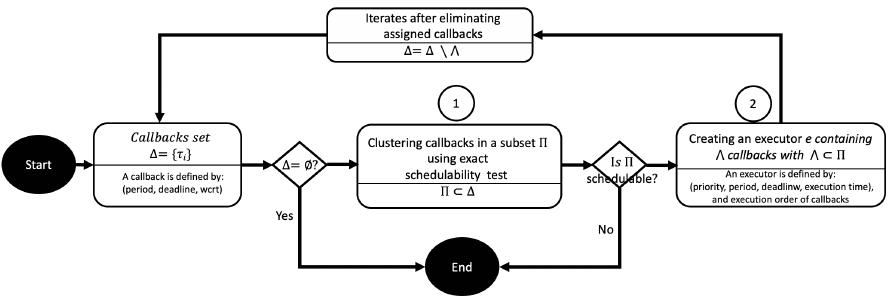
Figure 1. Main steps of the proposed